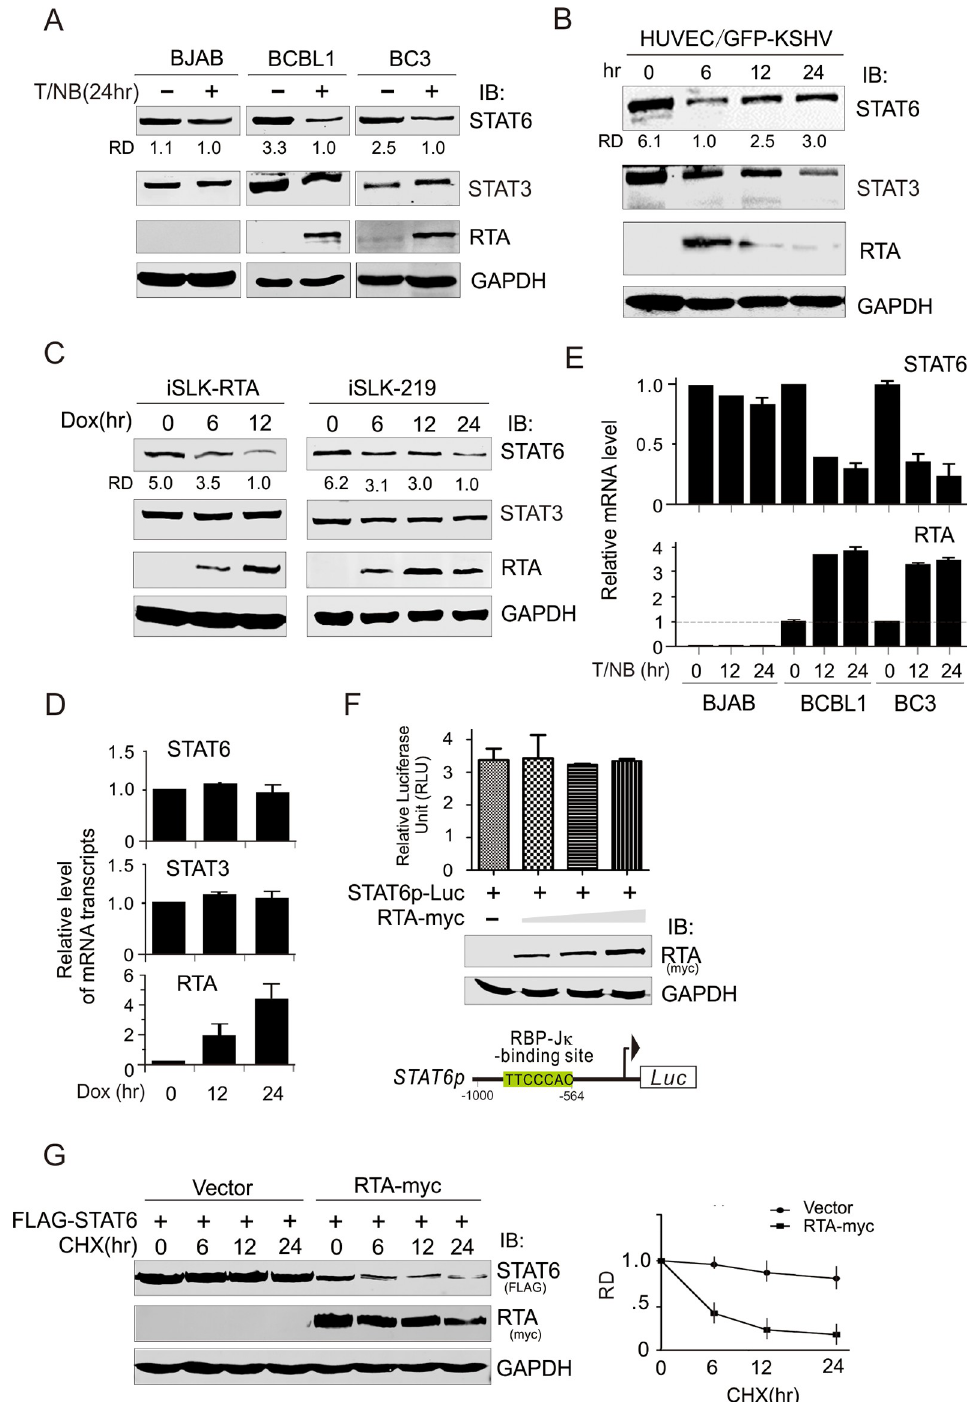
Fig 1. Expression of STAT6 is reduced during KSHV reactivation and early infection. (A) Expression of STAT6 but not STAT3 was dramatically reduced during KSHV reactivation. Whole cell lysates from KSHV-infected BCBL1 and BC3 and uninfected BJAB cells individually treated with or without 20 ng/ml of TPA and 1.5mM sodium butyrate (T/ NB) for 24 h, were subjected to immunoblotting (IB) with antibodies as indicated in the figure. The relative density (RD) of STAT6 protein band was quantitated. (B) Early infection of KSHV reduced STAT6 expression. Whole cell lysate from HUVEC cells with KSHV infection (GFP positive) at different time points, were subjected to immunoblotting (IB) with antibodies as indicated in the figure. (C) Doxycycloline (Dox)-induced RTA expression in iSLK-RTA or iSLK-219 cells